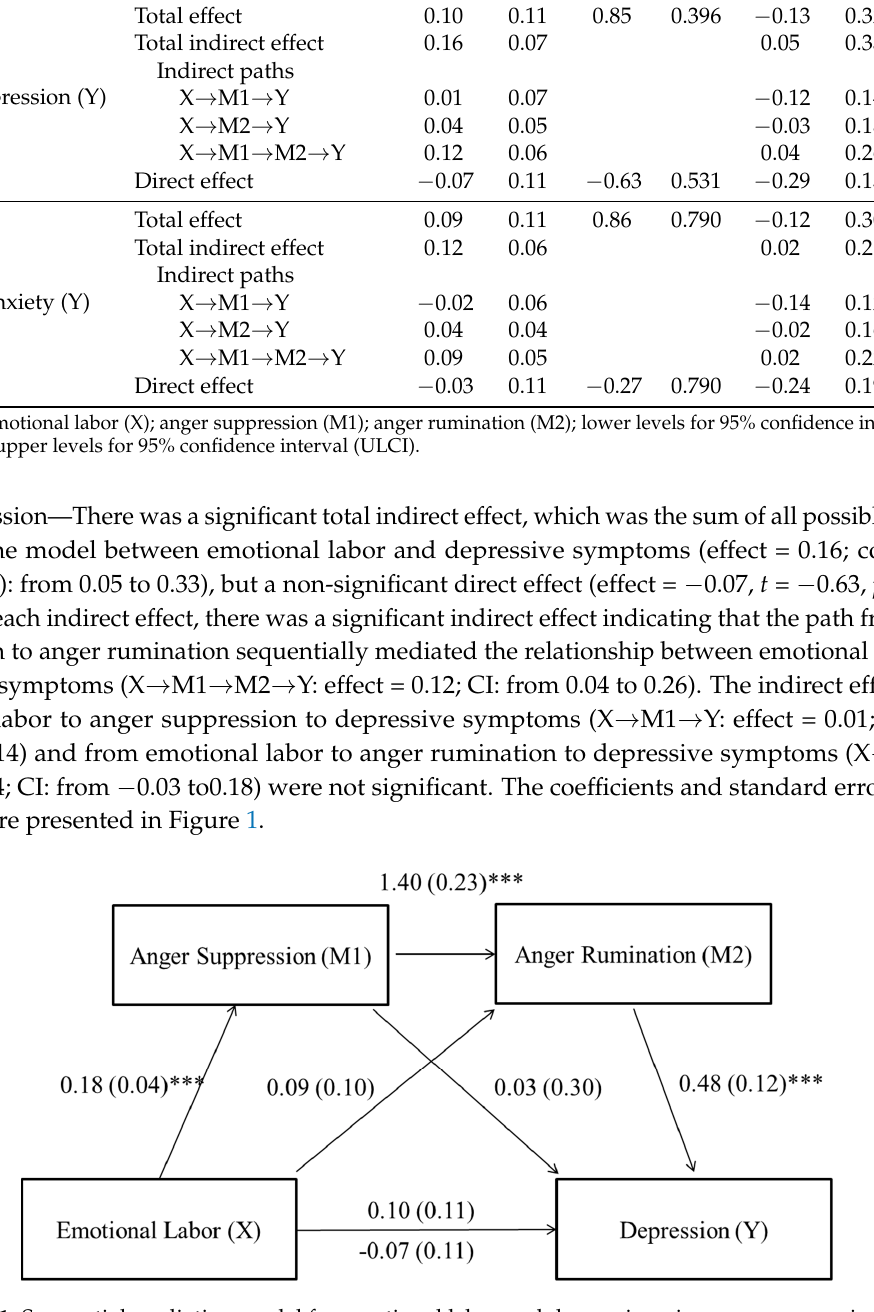
Figure 1. Sequential mediation model for emotional labor and depression via anger suppression and anger rumination. Unstandardized path coefficients and SE indicated above. The coefficient appearing above the line connecting emotional labor and depression represents the total effect and the coefficient below the line represents the direct effect. *** p < 0.001.